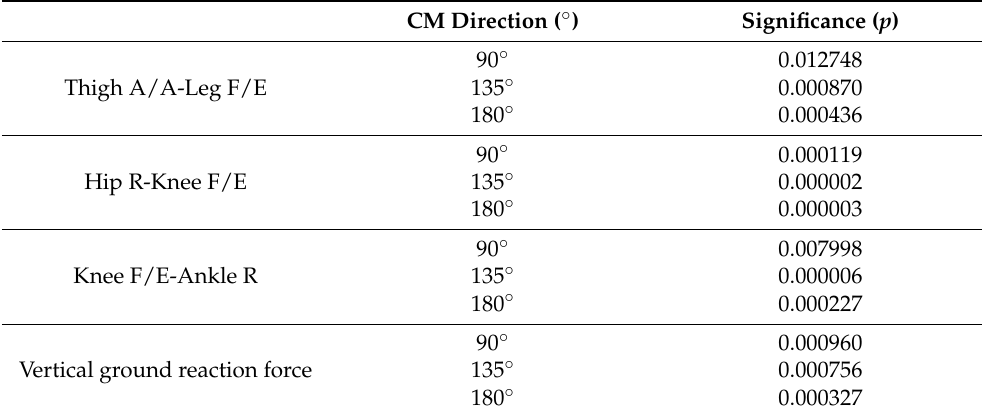
Table 1. The Shapiro-Wilk test for normality of vector coding values and vertical ground reaction in three CM